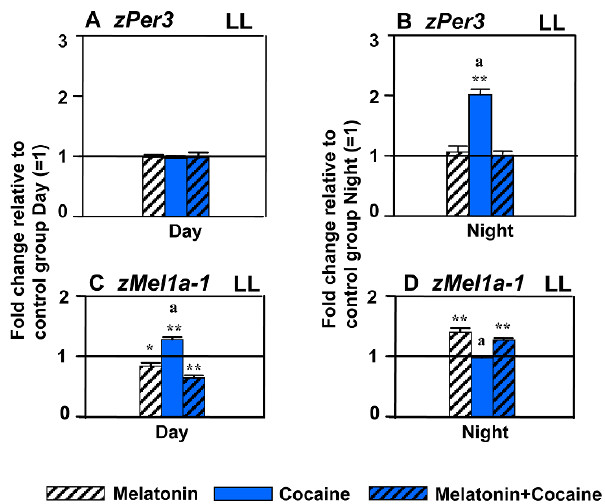
Figure 6. Constant light (LL) changes embryonic gene expression and magnitude of cocaine effects, while preserving circadian variation in cocaine and melatonin actions. Effects of melatonin, cocaine or their combination on gene expression display diurnal (circadian) variation in LL, similar to that in LD (Fig. 2), for both zPer-3 ( A vs. B ) or melatonin receptors ( C vs. D ). Treatment: Melatonin, 100 nM, 50 min or 20 min before cocaine. Cocaine: 30 m M, 20 min. Y-axis: fold change relative to corresponding, Day or Night, LL control (=1). N=3–4 samples/time point in LD or LL group, 25 embryos/sample. Mean 6 SEM, t -test (vs. control), * p , 0.05, ** p , 0.01, *** p , 0.001; One way ANOVA (between treatments), a: p , 0.05, vs. other two groups.